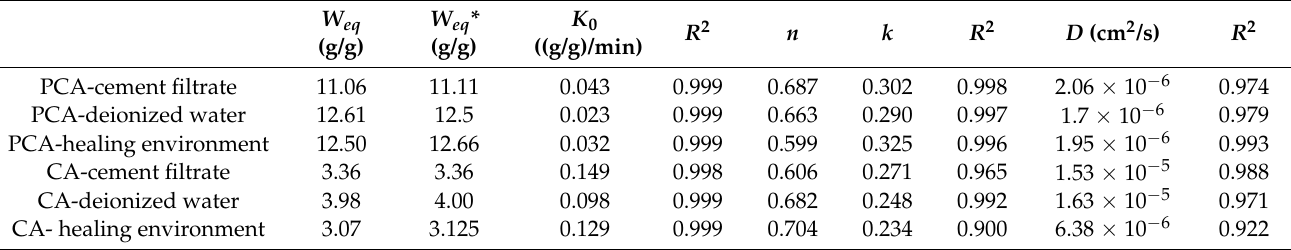
Figure 6. The swelling behaviors of PCA and CA in cement filtrate: ( a ) the swelling rate of two kinds of ca-alginate beads in cement filtrate over time, ( b ) The curve of ln ( W ( t )/ W eq ) over ln t , and ( c ) the curve of t / W ( t ) over t , ( d ) the curve of W ( t )/ W eq over t 1/2 . The ln ( W ( t )/ W eq ) to ln t curves of PCA and CA in cement filtrate are shown in Figure 6b. The relevant parameters n and k are obtained by linear fitting (shown in Table 3). The n values of PCA and CA in cement filtrate are both greater than 0.5, which means that the swellings of PCA and CA belong to non-Fickian swelling, and the diffusion rate of water is equivalent to the relaxation rate of ca-alginate beads. The similar n values indicate that the restriction of the molecular chain in the initial swelling of PCA is similar to that of CA. Table 3. The swelling parameters of two kinds of ca-alginate beads in cement filtrate, deionized water, and a healing